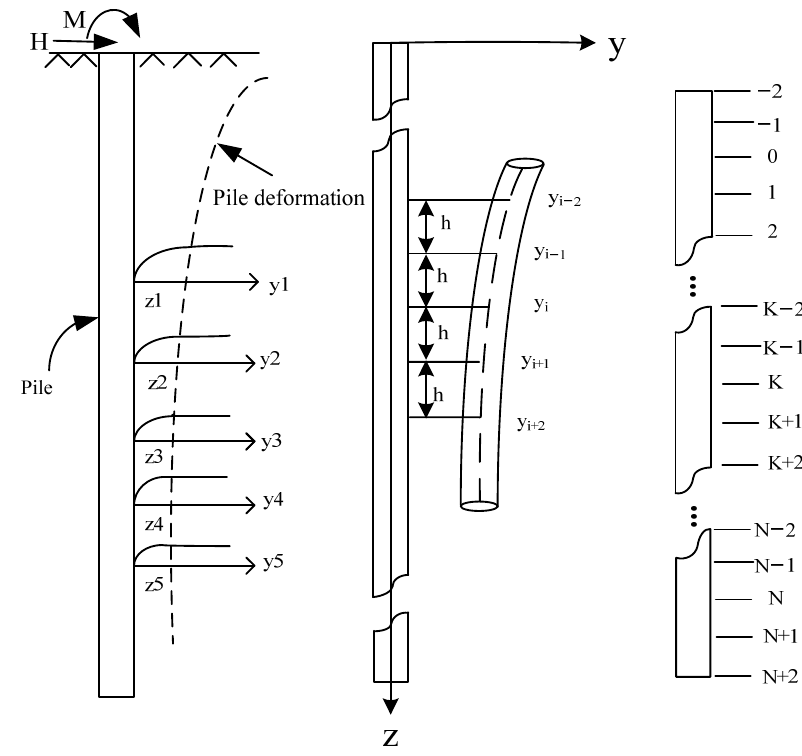
Figure 4. Deformation and difference diagram of the pile under horizontal load.